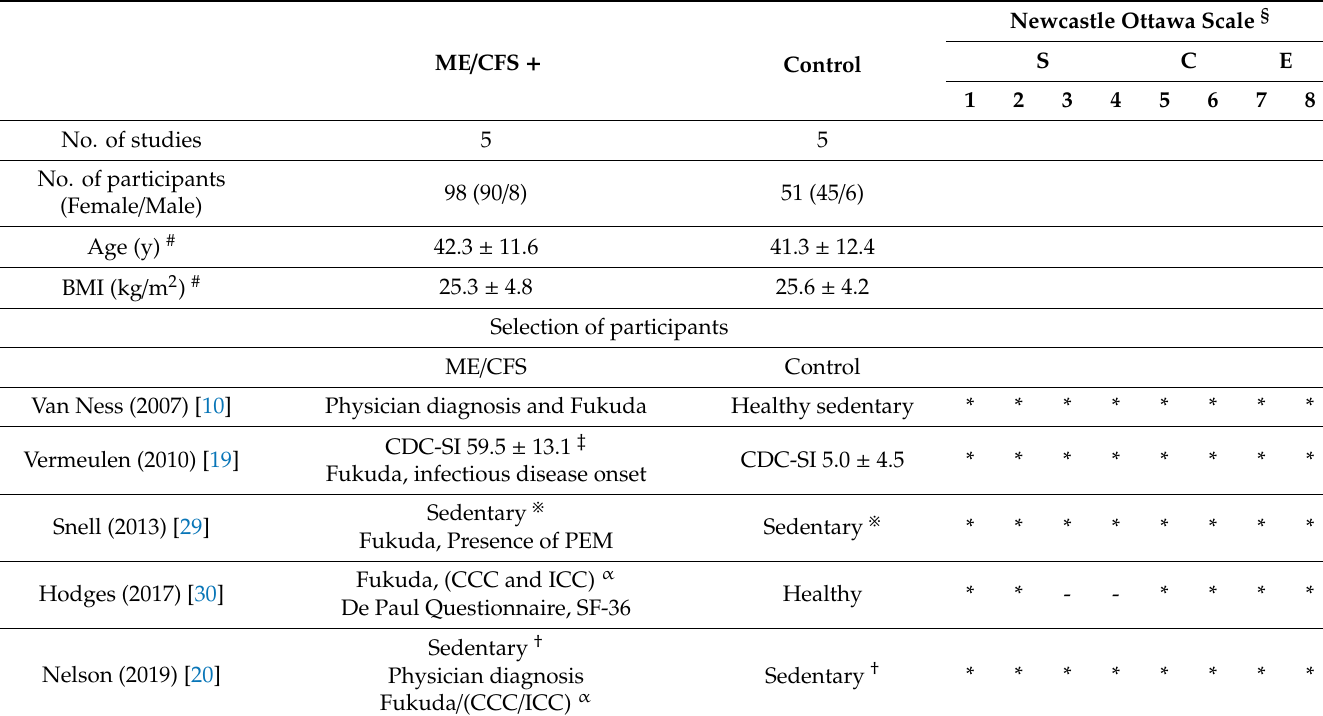
Table 1. Characteristics and assessment of quality of